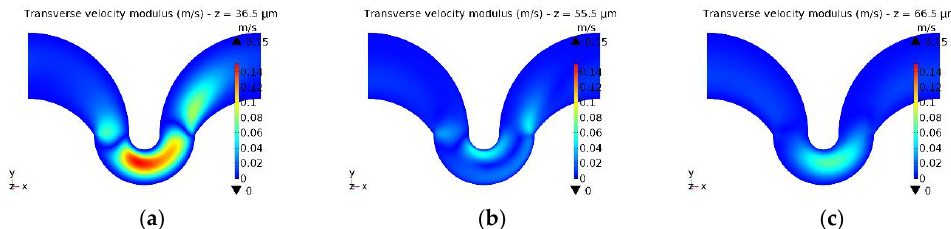
Figure 7. Modulus of the transverse flow field calculated at different heights. The transverse flow field strength is an order of magnitude weaker in the big curve. ( a ) At z = 36.5 μm (middle height), the magnitude for an outwards-moving flow is maximum; ( b ) At z = 55.5 μm, a null velocity region (the center of the upper Dean vortex) is visible in the central region of the small curve; ( c ) The magnitude of the velocity in the small curve increases again as we move upwards. This time, the flow is moving inwards, in the direction of the center of curvature.